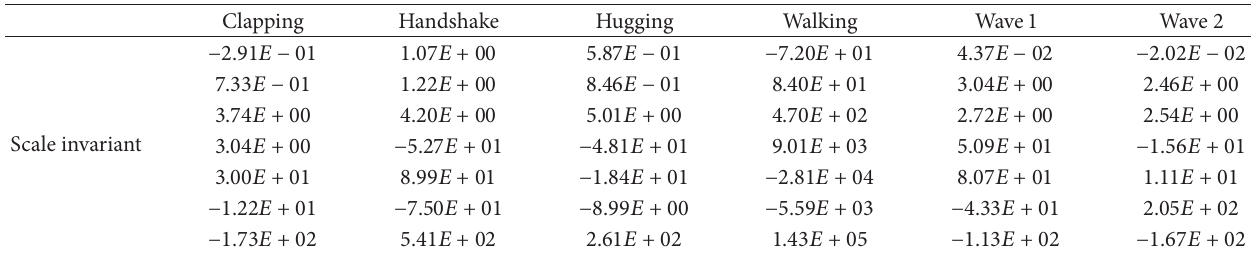
Table 4: The numerical comparison of scale invariant moments for each of the actions. Clapping Handshake Hugging Walking Wave 1